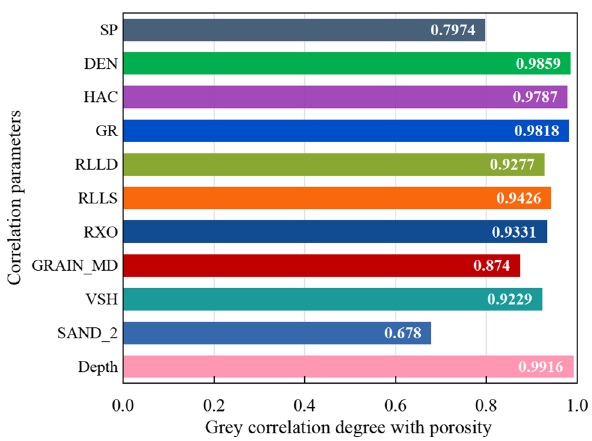
Fig. 6 Results of grey correlation analysis of the logging